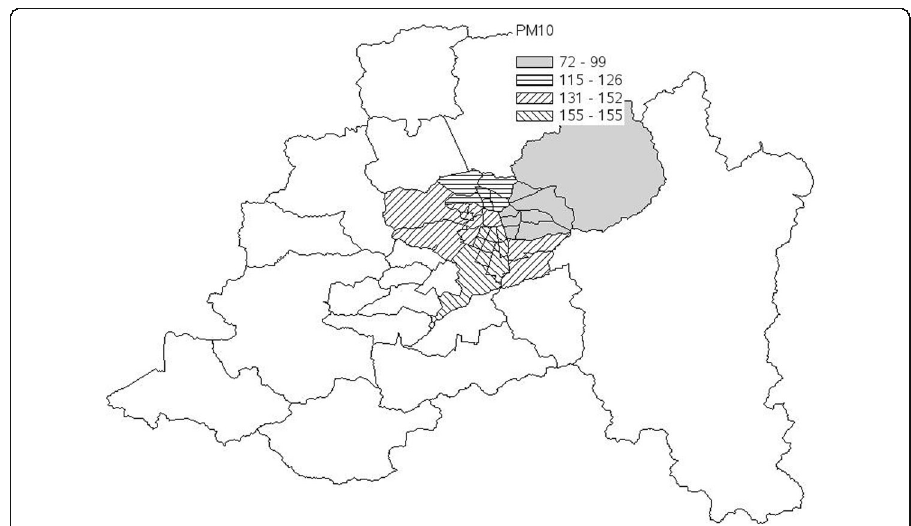
Fig. 2 Geographical distribution of PM 10 in Santiago, Chile, 2015. Notes: PM 10 in microgrammes per cubic metre. Data for the reference week of June, 2015. Municipalities are grouped by their corresponding strata in the employment survey. Municipalities in white are not covered in the employment survey. Source: Own elaboration from